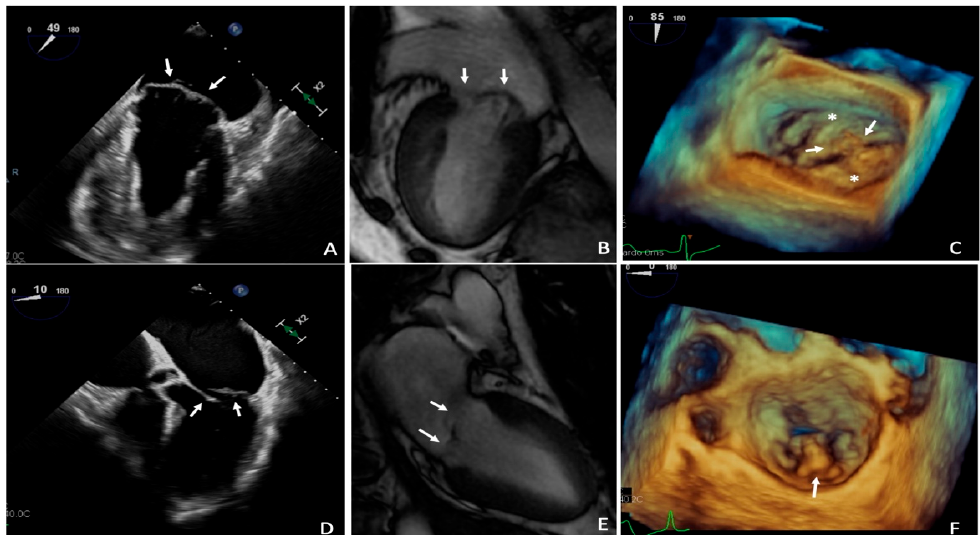
Figure 2. Multimodality assessment of MVP due to Barlow’s disease and due to fibroelastic deficiency; 2D TEE ( A ) and CMR ( B ) images show thickening and prolapse of both mitral valve leaflets in Barlow’s disease; 3D TEE ( C ) confirms mitral prolapse involving multiple segments of both leaflets (asterisks). Two ruptured chordae (arrows) are also visible; 2D TEE ( D ) and CMR ( E ) show thin mitral valve leaflets (arrows) with posterior leaflet flail confirmed by 3DTEE (( F ), arrow) in fibroelastic deficiency. CMR: Cardiac Magnetic Resonance; FED: Fibroelastic deficiency; TEE: Transeoesophageal